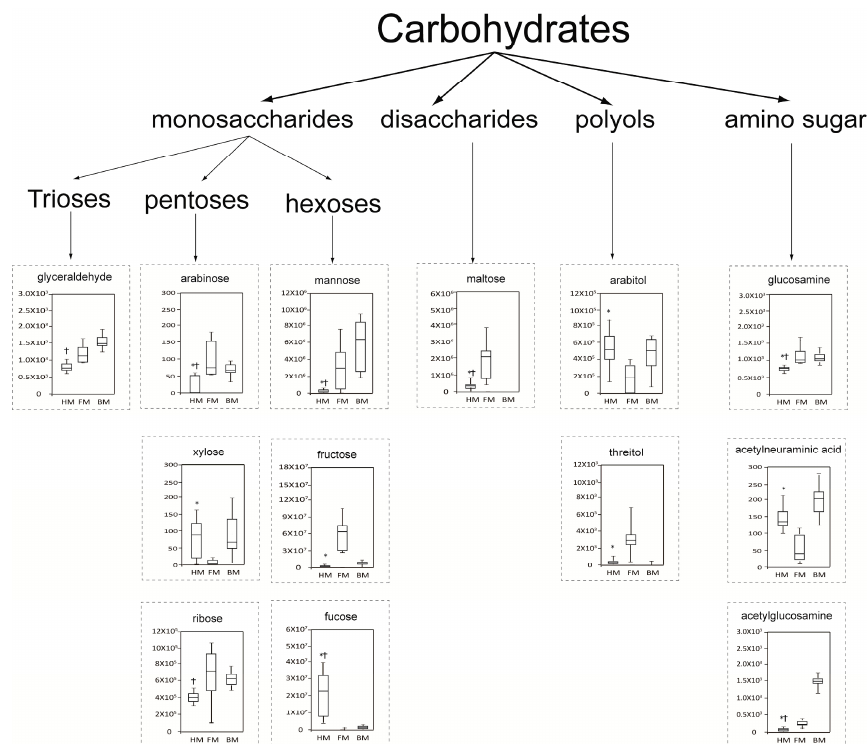
Figure 6. Bar plot of carbohydrates that significantly differed among HM, FM and BM. The Y-axis represents the normalized peak area. Boxes contain the 25%–75% measurements for each group, and whiskers cover the 5%–95% measurements. The horizontal lines within the box represent the median values. * p < 0.05 vs. FM; † p < 0.05 vs. BM. Kruskal–Wallis H test followed by